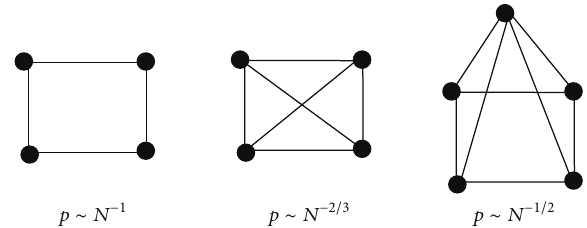
Figure 1: Threshold probabilities at which different subgraphs appear in a random